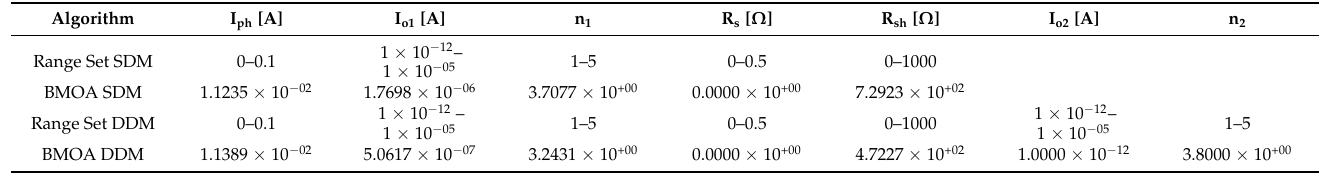
Figure 3 . Amorphous silicon photovoltaic cell: ( a ) measured and calculated I-V characteristic for SDM; ( b ) measured and calculated I-V characteristic for DDM; ( c ) SDM and DDM errors comparison. Table 6. Amorphous silicon photovoltaic cell parameters and range.